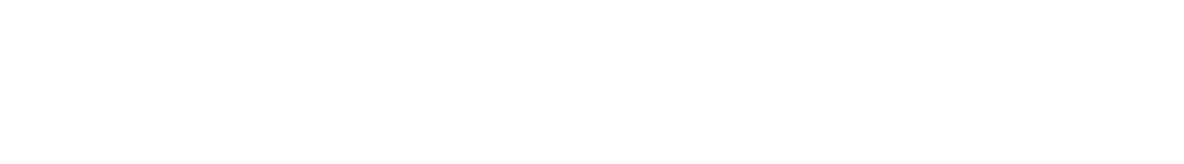
Frontiers in Earth Science |